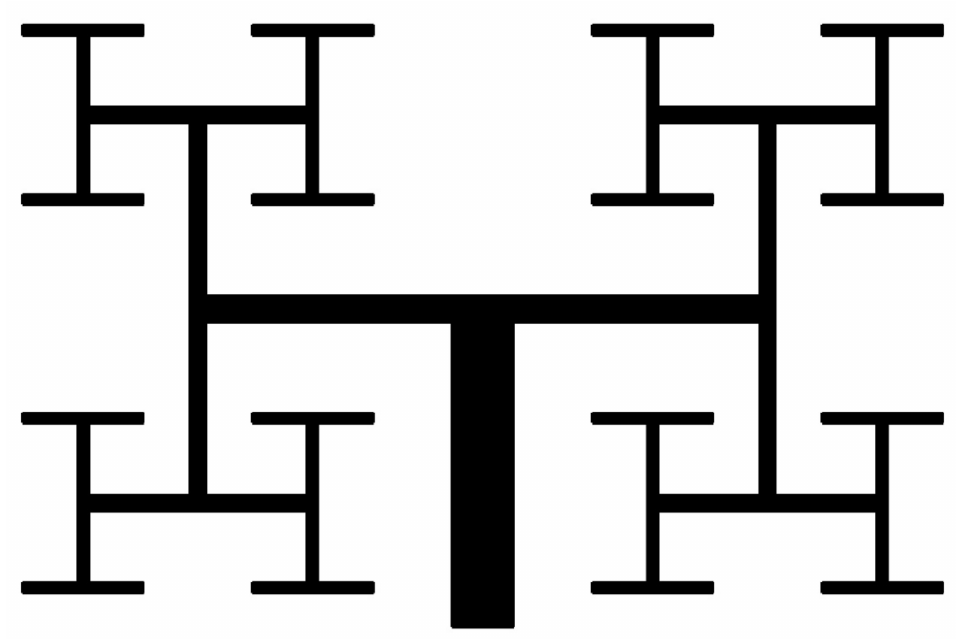
Figure 29. A typical tree-shaped configuration filling in a rectangle plane [241].